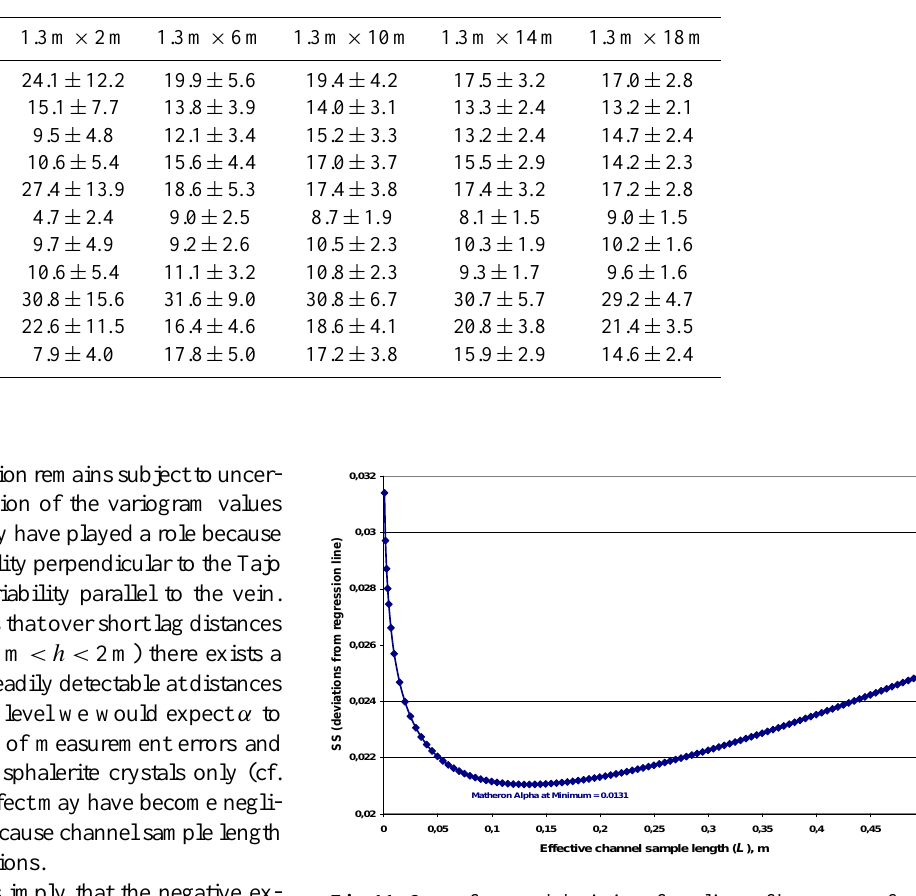
Table 2. Zinc concentration values (in %) with 95% confidence intervals for thin plates elongated in the direction of themining drift with channel samples at their centers. Results are shown for every 10th value in the original seriesof 118 Pulacayo zinc values. Error bars for 1.3m × 2m are too wide because small-scale spatial correlationis not being considered.